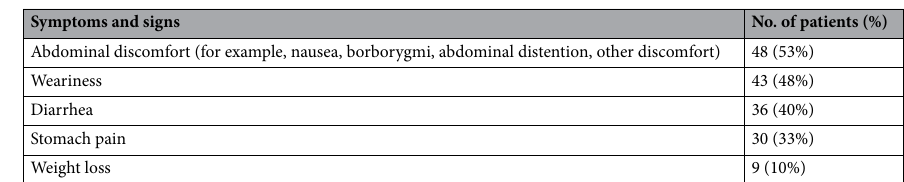
Table 2. Symptoms and signs causing contact with the health service in 90 patients with newly diagnosed celiac disease.